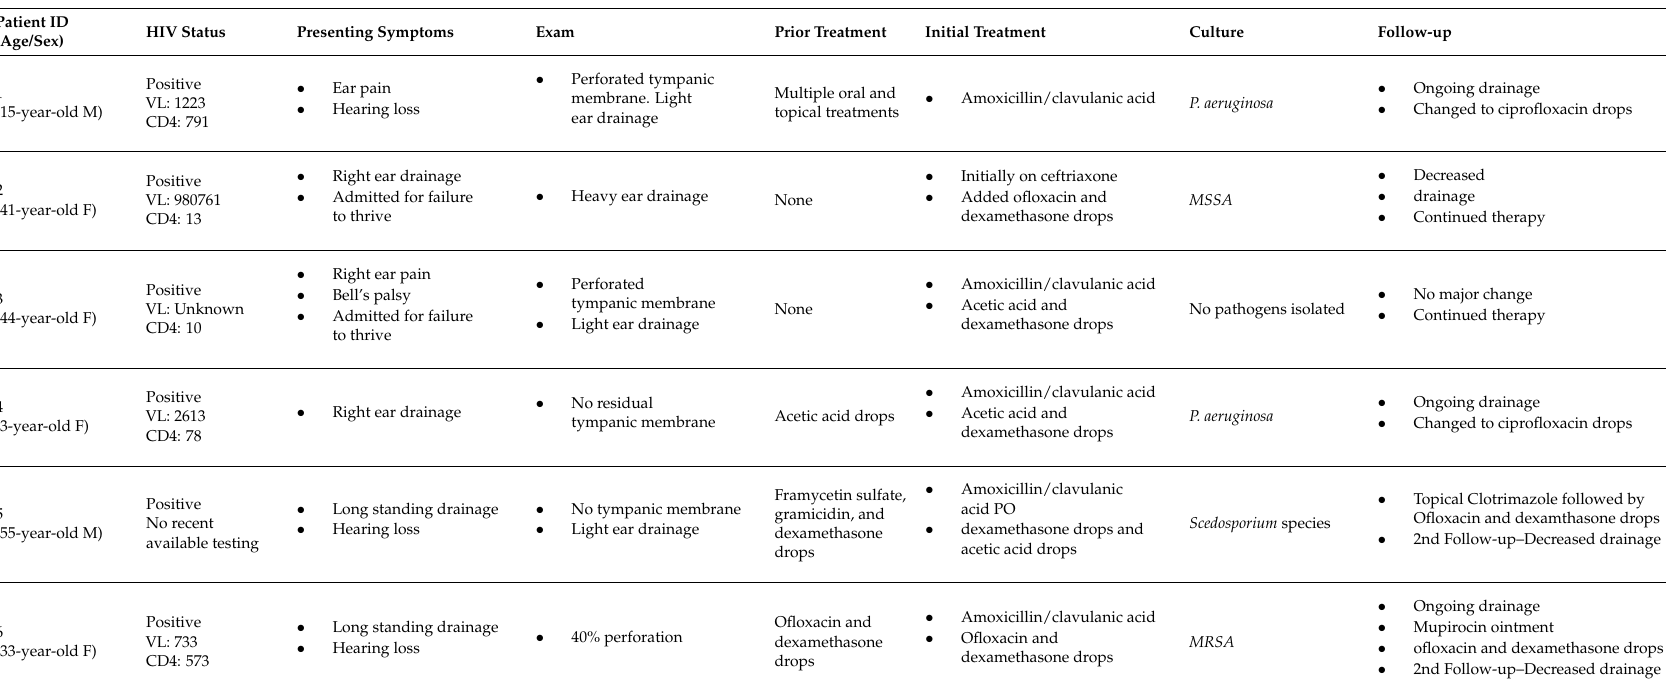
Table 1. Patient presentation and management. Presenting characteristics, exam findings, prior therapy, initial study therapy, culture results, and alterations in therapy based on culture results for the six patients with prior medical